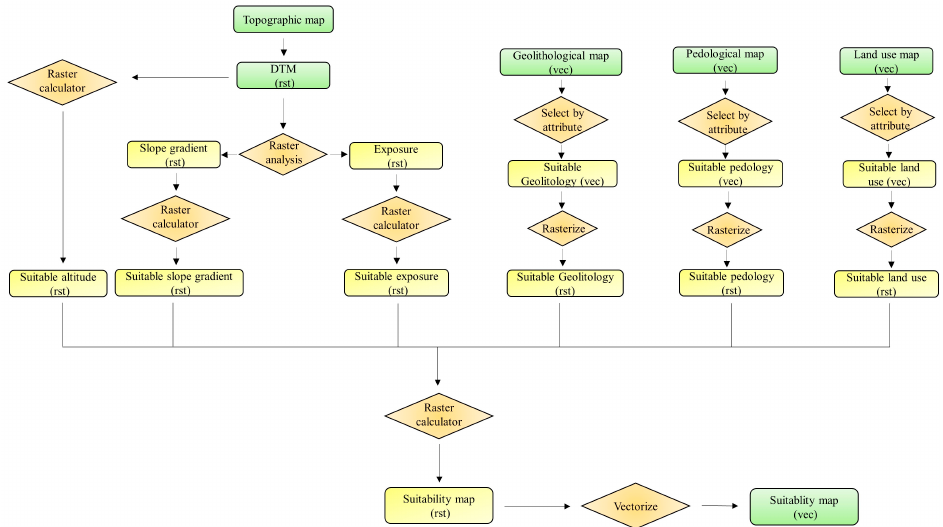
Figure 3. Flowchart of GIS-based processing for suitability map building. Between brackets, rst and vec indicate raster and vector file types,